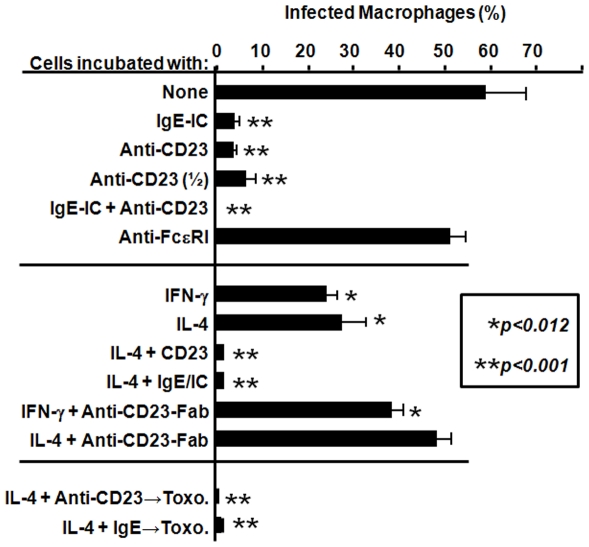
IgE-IC induces toxoplasmacidal activity of human macrophages through FcεRII/CD23 ligation.
T. gondii-infected macrophages were incubated in the presence of IgE-IC, cross-linking anti-FcεRI (20 µg/ml), or anti-FcεRII (10, 20 µg/ml) McAb and the percentage of infected cells was assessed following 72 h incubation. Only IgE-IC and anti-FcεRII induced parasite elimination (upper panel). Infected cell incubation with recombinant IL-4 or IFN-γ induced parasite killing, reversed by the simultaneous blockade of CD23 cross-linking by Fab fragments of anti-CD23 McAb (20 µg/ml) (median panel). Cells were also treated 24 h with IL-4 and IgE-IC or anti-CD23 prior to cell infection. The lower panel shows that pretreatment of macrophages during 24 h with CD23 ligands enabled them to resist to T. gondii infection. Results show mean±SD from 3 distinct macrophage preparations, each done in duplicates. Asterisks show significance compared to infected cells cultured in medium alone.